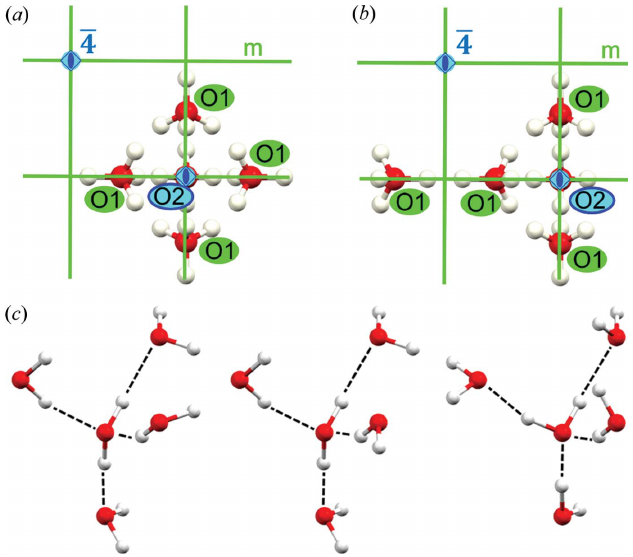
Figure 2 Selected symmetry elements in the structure of ice VI. Glide planes and inversion centers were removed for clarity: ( a ) O2 and its closest environment, ( b ) O1 and its closest environment, ( c ) examples of water clusters selected out of 259 configurations used in the HAR.